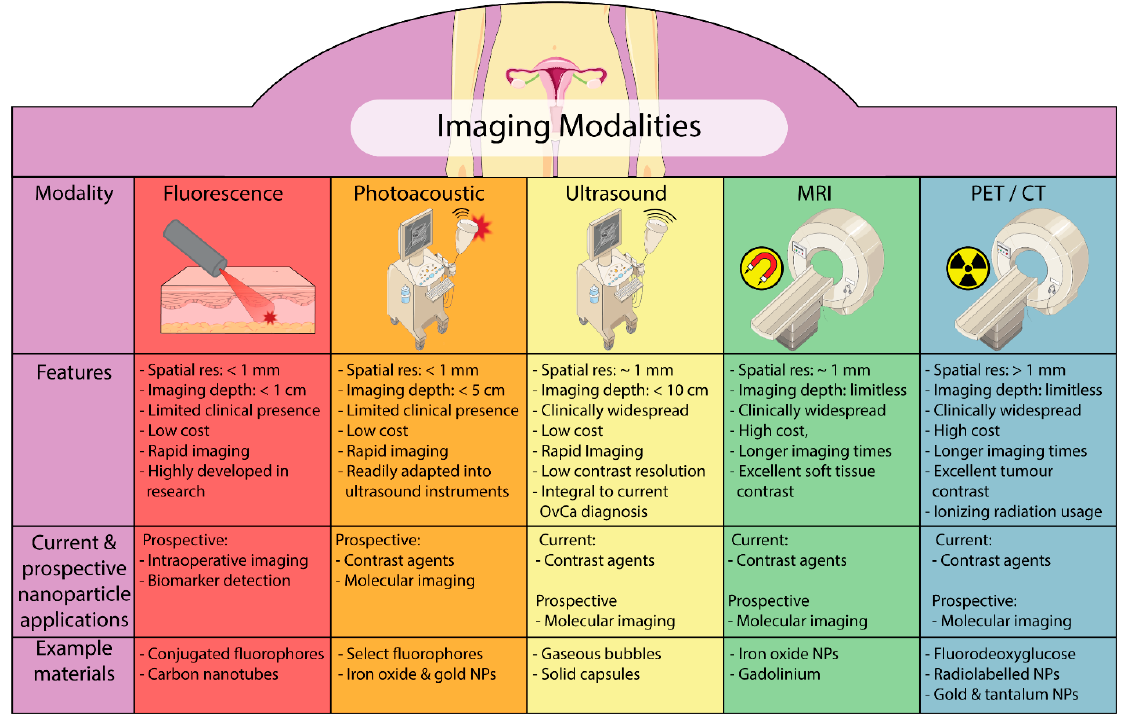
Figure 3. Schematic illustration of the five main modalities of imaging in ovarian cancer: fluorescence, photoacoustics, ultrasound, positron emission tomography/computed tomography and magnetic resonance imaging. In addition, an overview of the features of the modalities and their current and prospective applications related to nanoparticles is also briefly detailed, and some example materials that have been used in the literature are